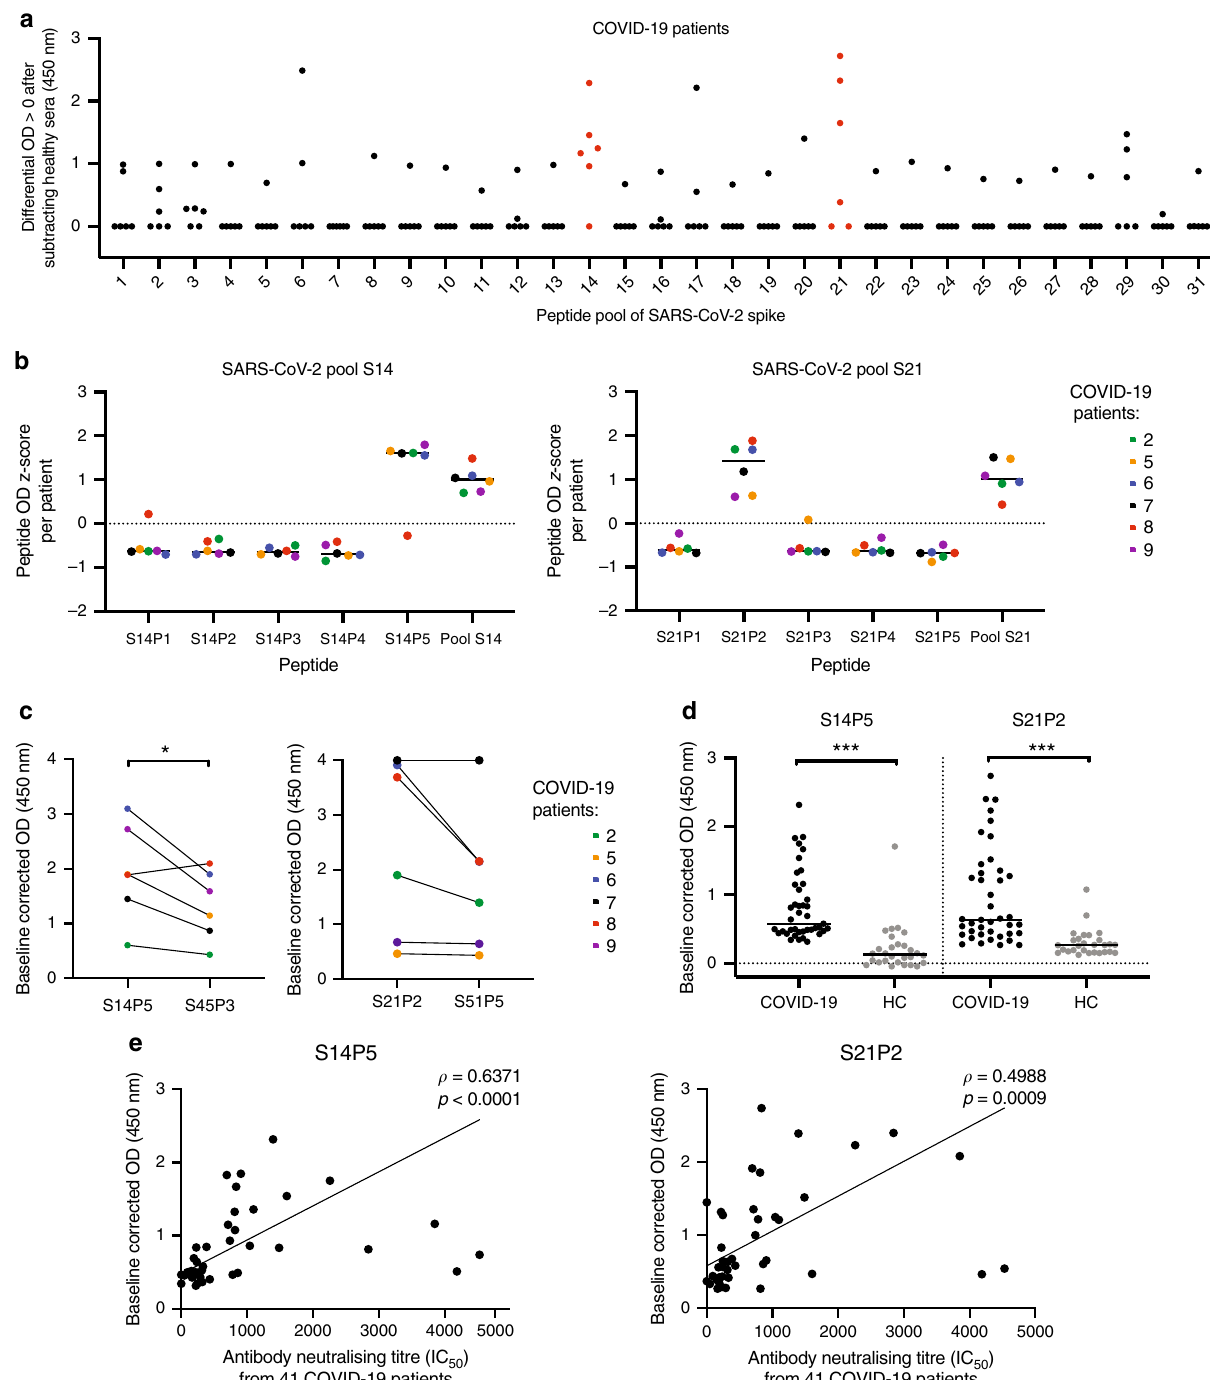
Antibody neutralising titre (IC 50 ) from 41 COVID-19